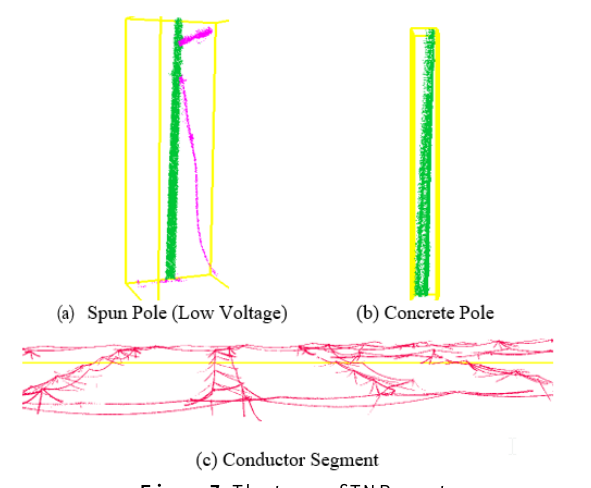
Figure 7 . The types of TNB assets